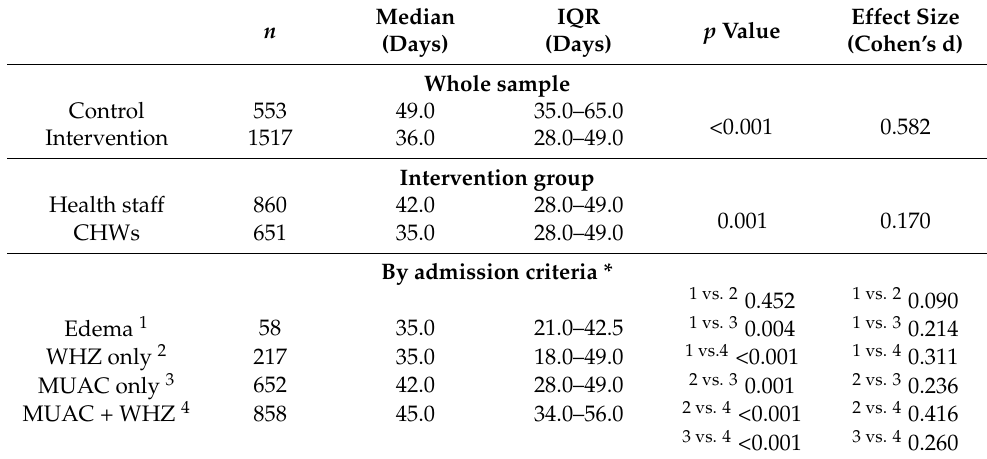
Table 5. Recovery time from uncomplicated severe acute malnutrition compared between study groups and by health provider inside the intervention group.